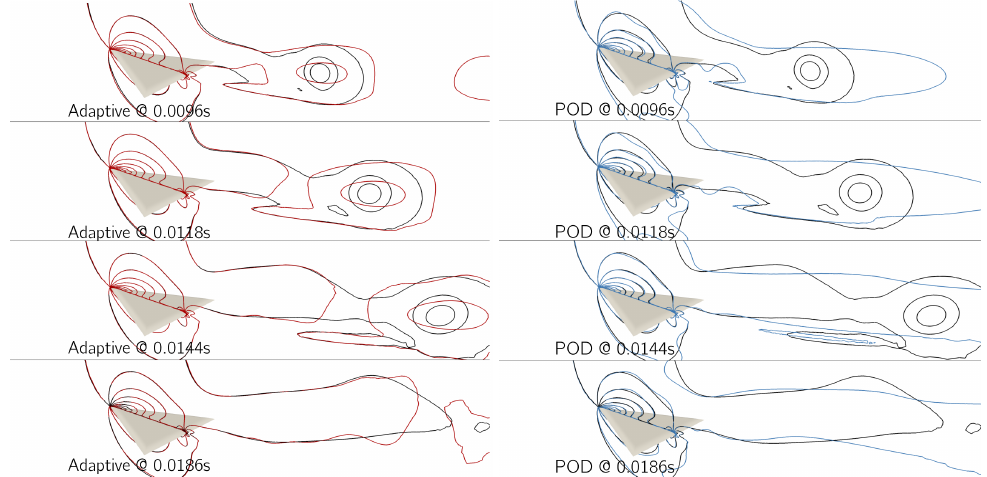
Figure 15. Comparison of volume solution in terms of ρ for the delta wing test case. The black contours report the CFD reference solution; the coloured contour lines show the ROM reconstruc- tion. The left column shows the adaptive reconstruction; the right column shows the pure POD reconstruction. Number of modes fixed, N m =